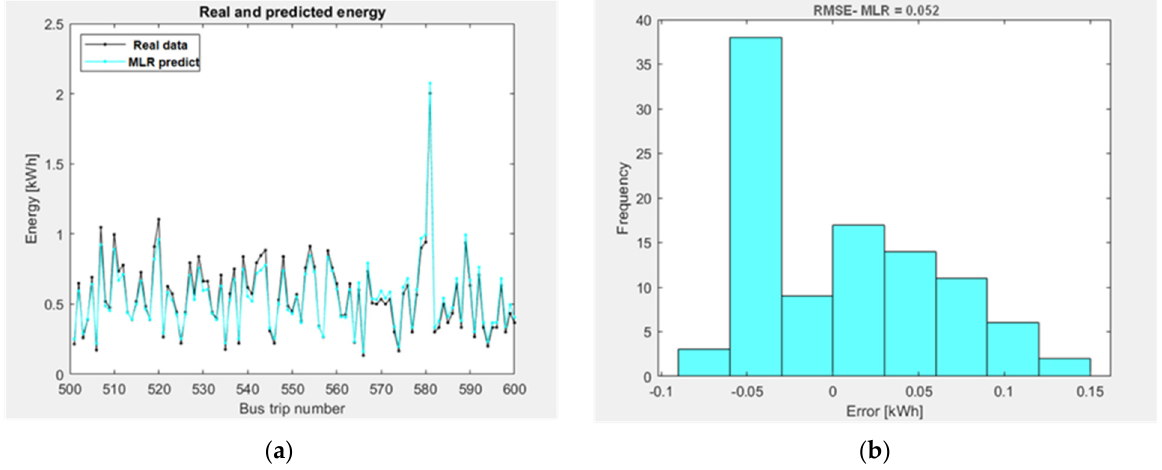
Figure 13. ( a ) Real and predicted energy consumption for test data from 501 to 600; ( b ) Histogram for RMSE errors for MLR models for 100 test data.